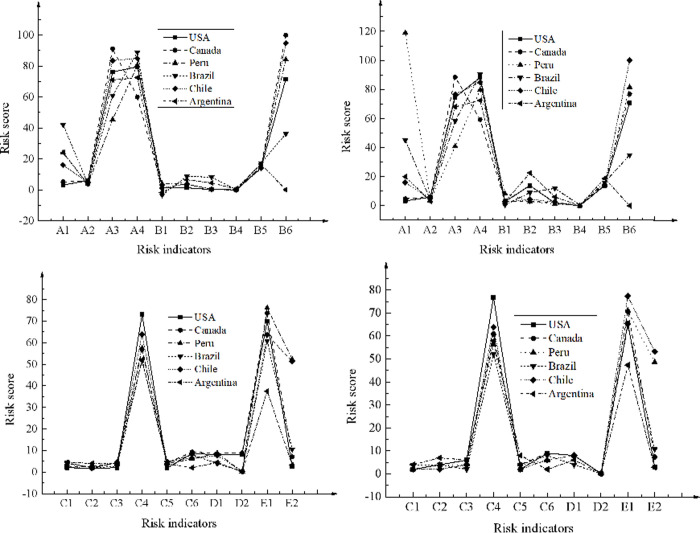
The results of the overseas investment risk assessment of North America and Latin America country clusters in 2018–2019.(a) Risk categories of basic resources and economic and finance in 2018; (b) Risk categories of political system, environmental protection, and resources and energy in 2018; (c) Risk categories of basic resources and economic and finance in 2019; (d) Risk categories of political system, environmental protection, and resources and energy in 2019.